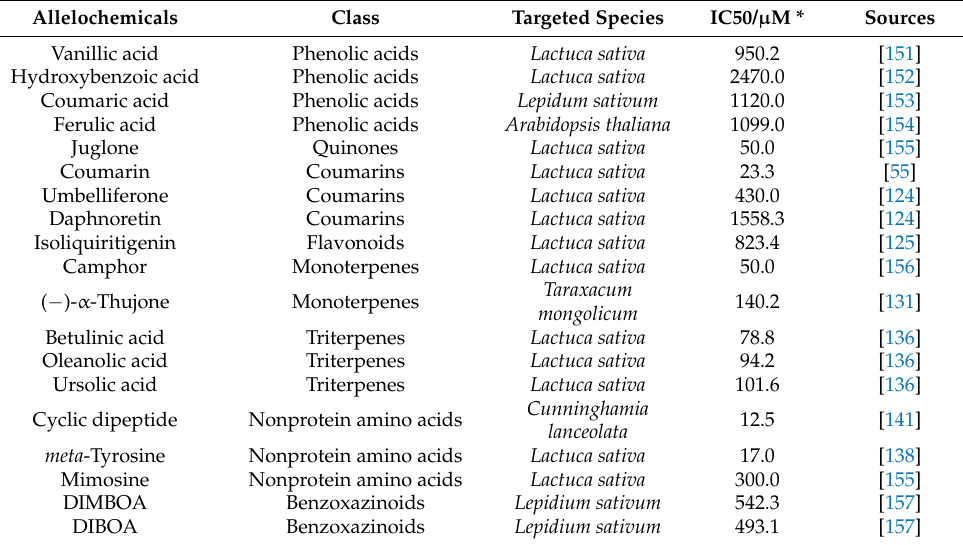
Table 1. The phytotoxic level of important allelochemicals in grasslands and